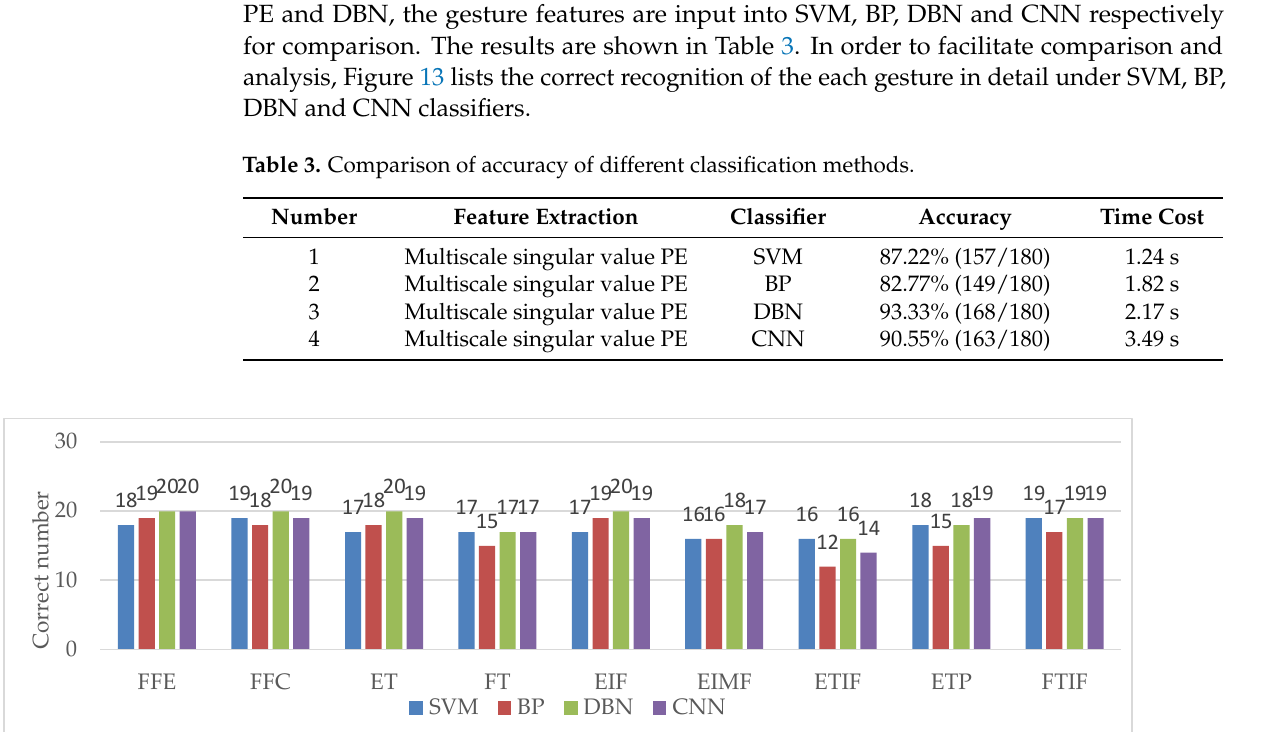
Figure 12. Accuracy of the deep belief network (DBN) system: ( a ) relationship between hidden layers and accuracy; ( b ) relationship between hidden cells and accuracy; and ( c ) relationship between training samples and accuracy.